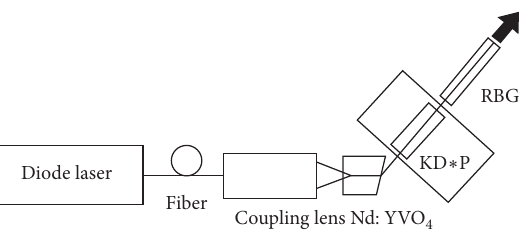
Figure 11: SLM laser based on RBG